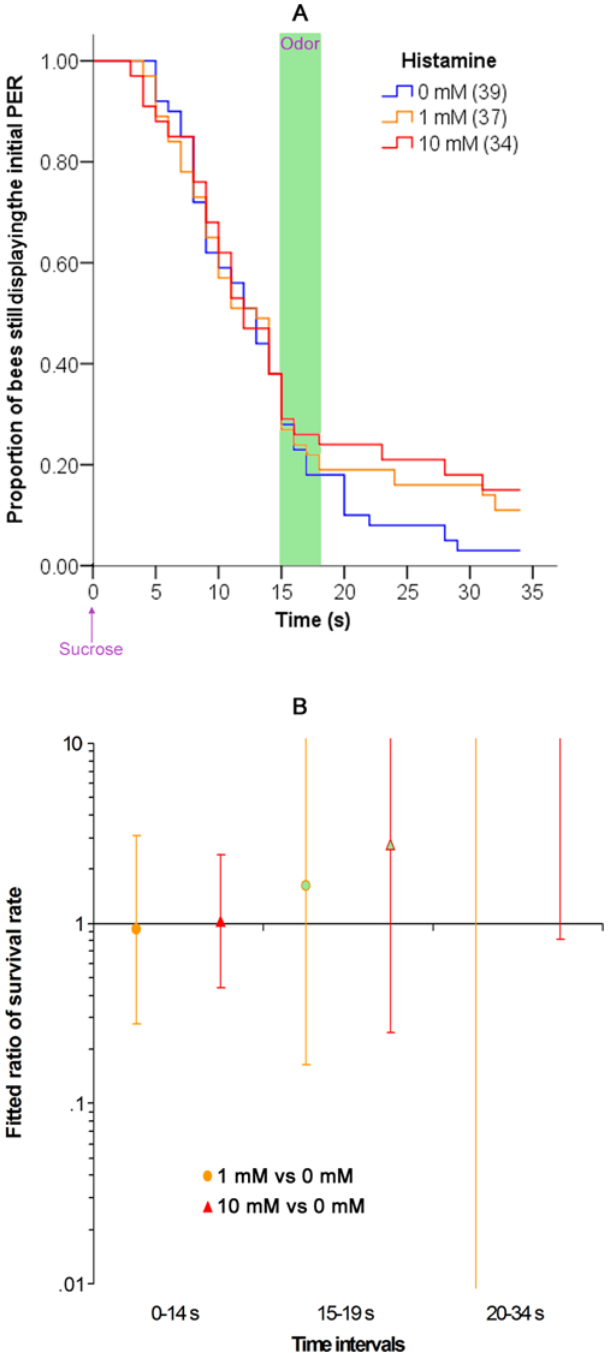
Figure 9. Effect of histamine on olfactory interference. (A) Proportion of bees that are still releasing the initial PER as a function of the time after the onset of the sucrose feeding. There were three groups of bees: animals injected into the deutocerebrum with 0 mM (control), with 1 mM or with 10 mM of histamine 15 minutes before starting the experiment. The odor (either 1-nonanol or octanal) were presented 15 s after the onset of the sucrose feeding, during 4 s. Other details are as in Figure 1A. (B) Ratio of the ‘‘survival rate’’ of the PER in the Cox regression for bees treated with 0 mM, 1 mM or 10 mM of cimetidine. The data are presented as in figure 1B.